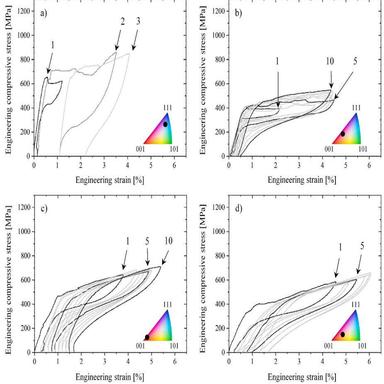
Engineering compressive stress vs. engineering strain hysteresis loops of the SE of the four specimens with different crystallographic orientations according to the loading axis as indicated in the stereographic standard triangle: (a) close to 〈111〉, (b) close to 〈113〉, (c) close to 〈001〉 and (d) close to 〈013〉.